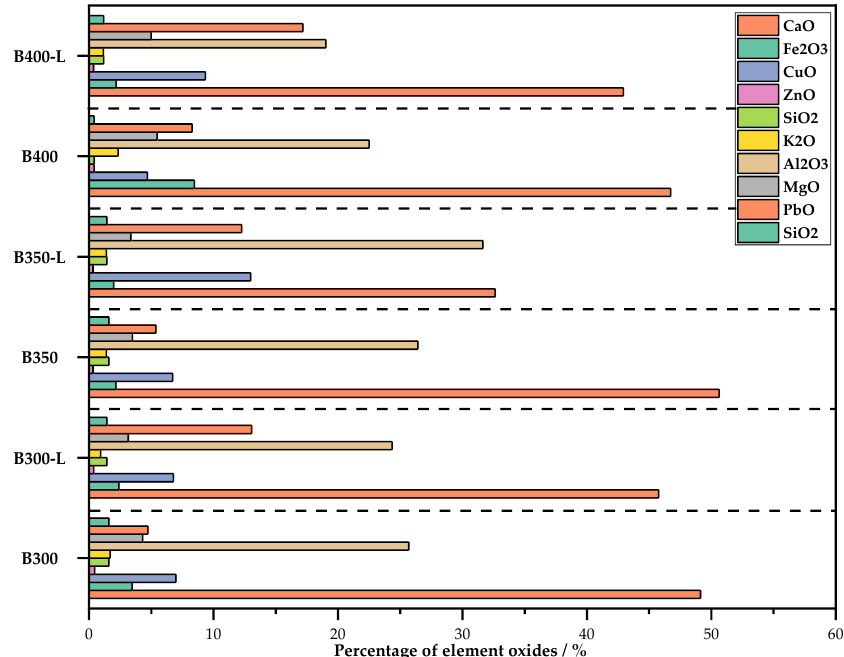
Figure 2. Composition of biochar ash elements expressed in oxides.